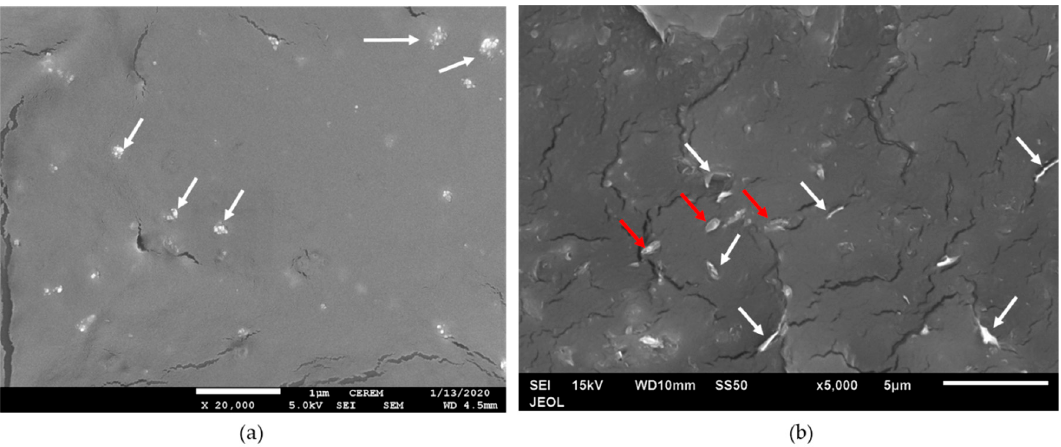
Figure 6. SEM images of microstructures of ( a ) PP/10CF/ nTiO 2 , and ( b ) PP/10CF/5GNP.